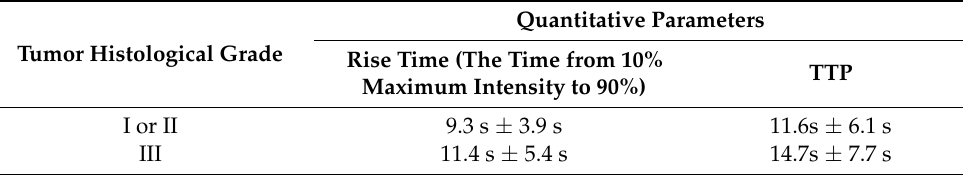
Table 4. Quantitative parameters variability depending on the tumor’s histological grade. Quantitative Parameters Tumor Histological Grade Rise Time (The Time from 10%